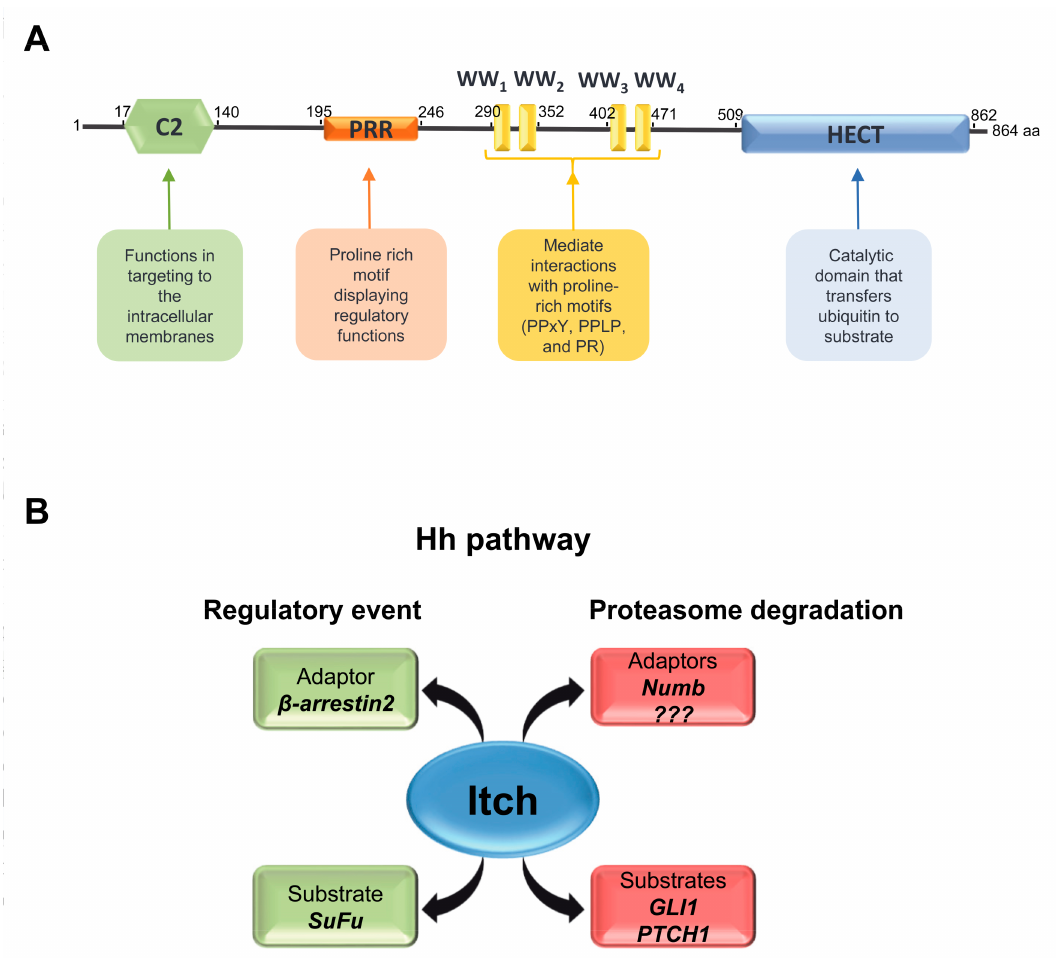
Figure 2. Schematic representation of the modular structure of Itch and its involvement in Hh pathway regulation. ( A ) Itch protein consists of an N-terminal Ca 2+ /lipid-binding (C2) domain (green hexagon), a proline rich motif (orange rectangle) displaying regulatory functions, a central region containing four WW domains (yellow bars) involved in protein-protein interaction and a catalytic HECT domain (blue rectangle). ( B ) The scheme shows the substrates of Itch involved in the regulation of Hh pathway (SuFu, GLI1 and PTCH1). Itch mediates regulatory events on SuFu and proteasome degradation on GLI1 and PTCH1 by the interaction with the adaptor proteins β -arrestin2 and Numb,